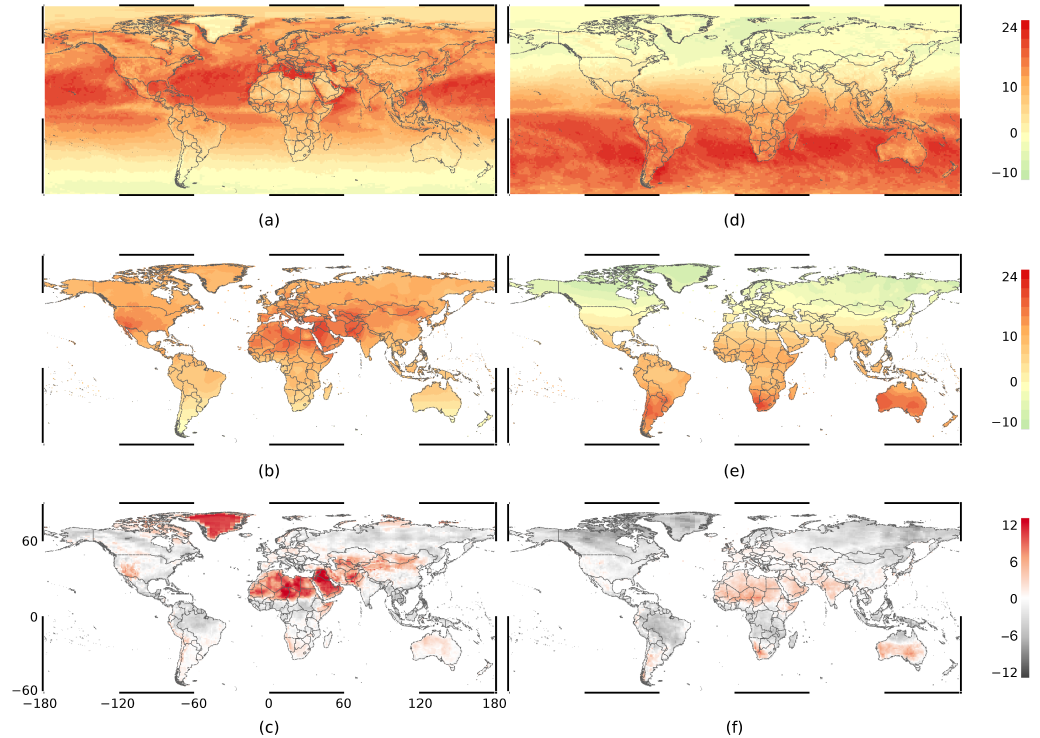
Figure 6. Global mean net downward surface radiation flux (MJm − 2 ) for June (left) and December (right) 2000 CE from CERES EBAF (top), from the SPLASH model (middle), and showing the differences between SPLASH and CERES EBAF (bottom). (a) CERES EBAF June 2000; (b) SPLASH June 2000; (c) difference between SPLASH and CERES EBAF June 2000; (d) CERES EBAF December 2000; (e) SPLASH December 2000; and (f) difference between SPLASH and CERES EBAF December 2000. Color bars on the right are linear interpolations of results in megajoules per square meter. Differences in red indicate higher SPLASH model